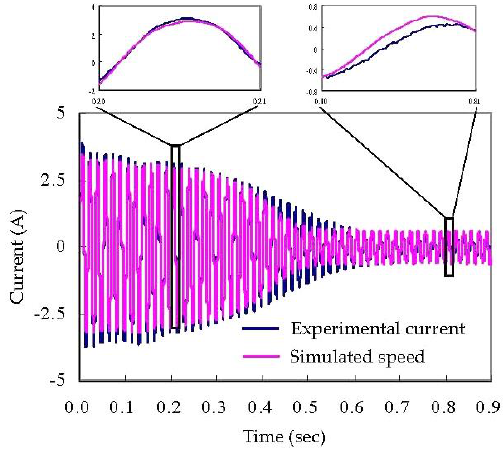
Figure 7. Comparison of currents.